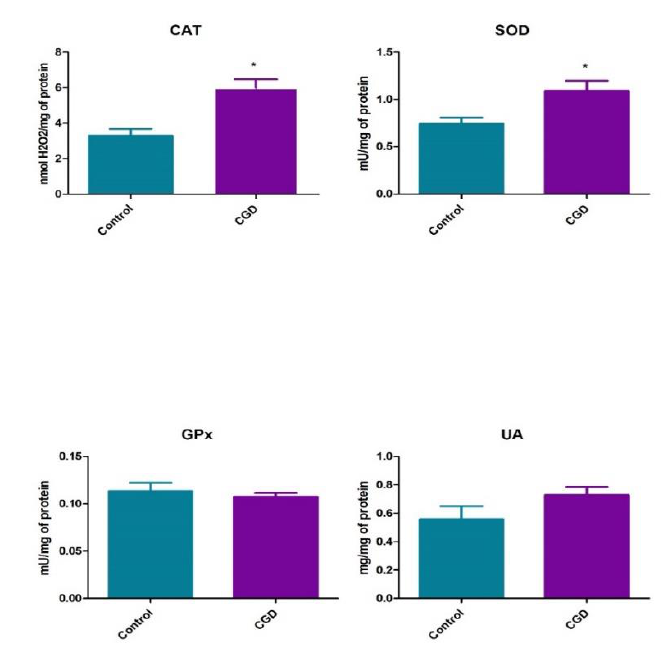
Figure 3. Enzymatic and non-enzymatic antioxidants in patients with CGD as well as healthy controls. CAT, catalase; SOD, superoxide dismutase; GPx, glutathione peroxidase; UA, uric acid. Differences statistically significant at * p < 0.05.